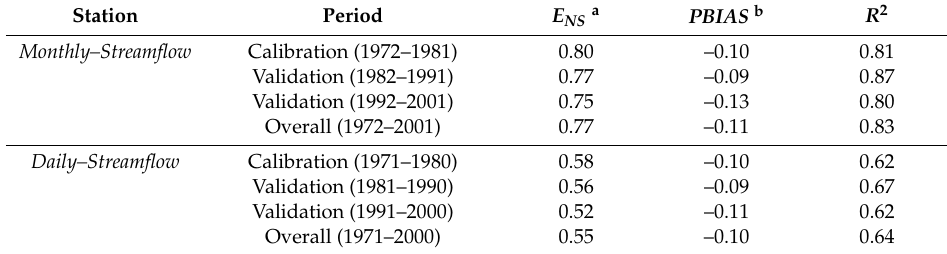
Table 2. Accuracy of the SWAT model calibration and validation in the Upper Honganjian